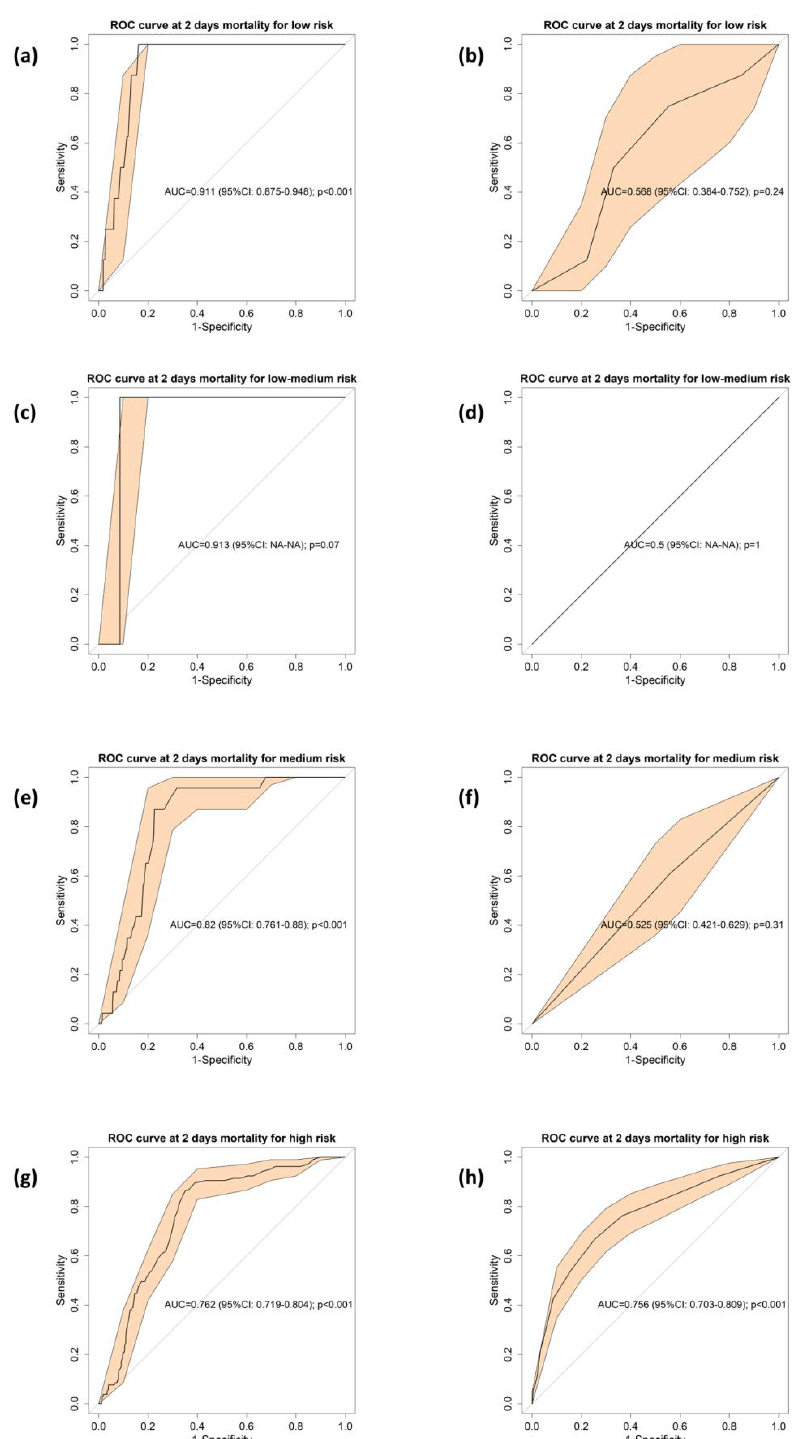
Figure 3. Receiver operational characteristic (ROC) of pLA for early mortality based on the stratification of the risk of mortality. ( a ) Low risk, ( c ) low-intermediate risk, ( e ) intermediate risk, ( g ) high risk; and ROC of NEWS2 for early mortality based on the stratification of the risk of mortality ( b ) low risk, ( d ) low-intermediate risk, ( f ) intermediate risk, ( h ) high risk. The bold line shows the value of the ROC curve and the orange shading is the 95% confidence interval. In the center of the graph is the area under the curve (AUC), its 95% confidence interval, and the p -value of the comparison against the null hypothesis (AUC =